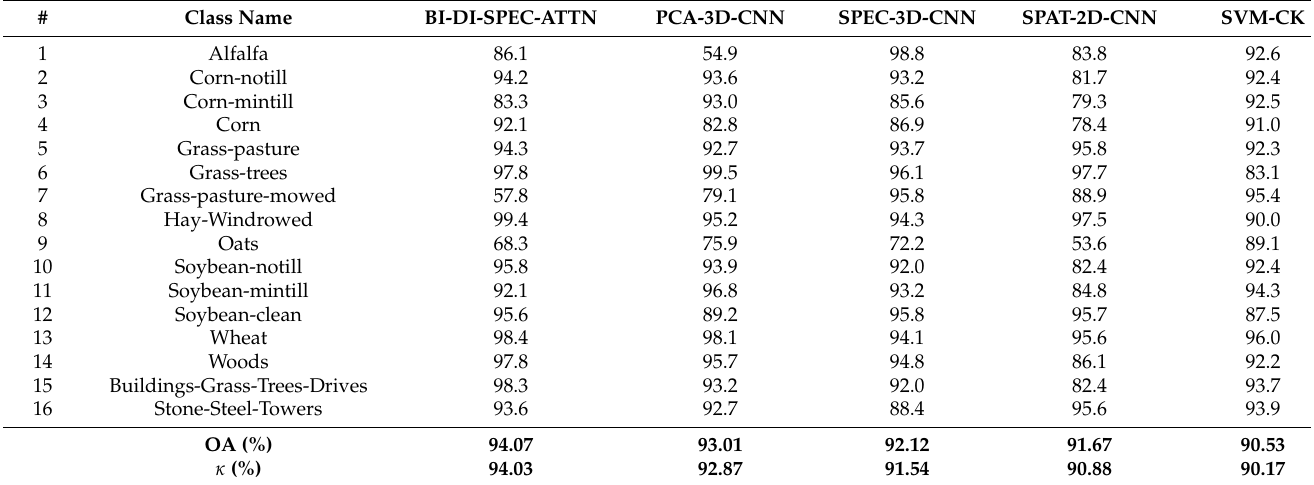
Table 4. Class-specific accuracies of Indian Pines dataset with 10% of training data for the proposed methodology and other models used for comparison.